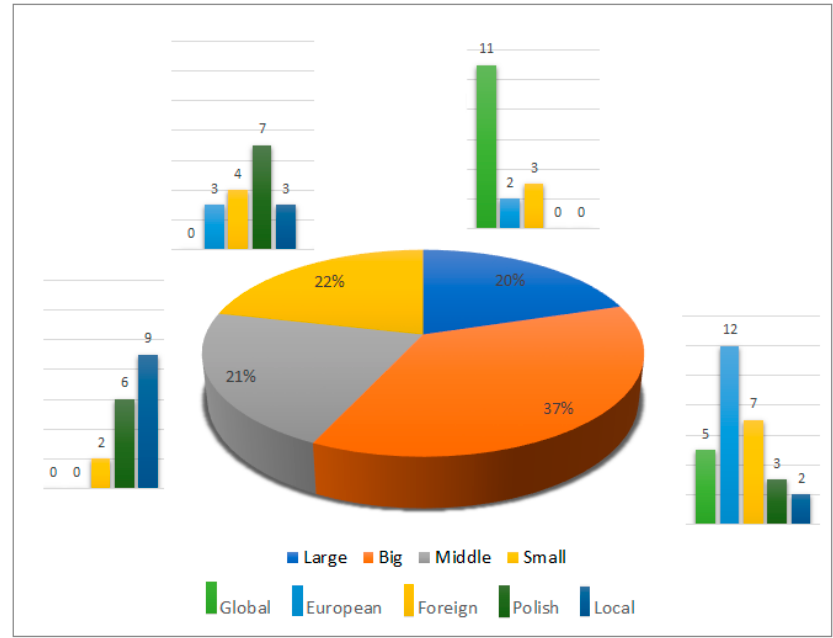
Figure 2. The structure of studied enterprises in pilot direct research. Source: own research